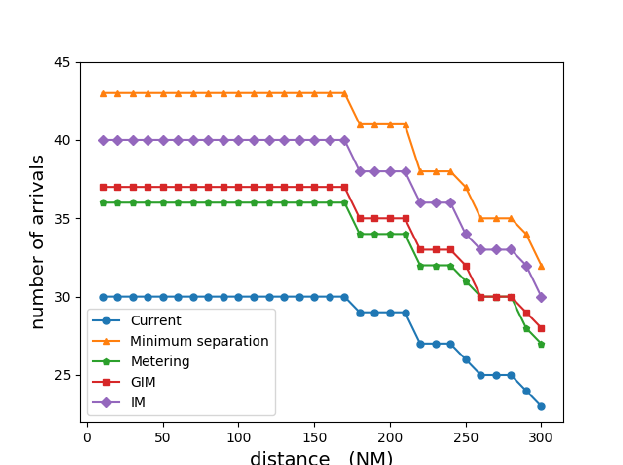
Figure 12. Future demand subject to increasing arrival rate.